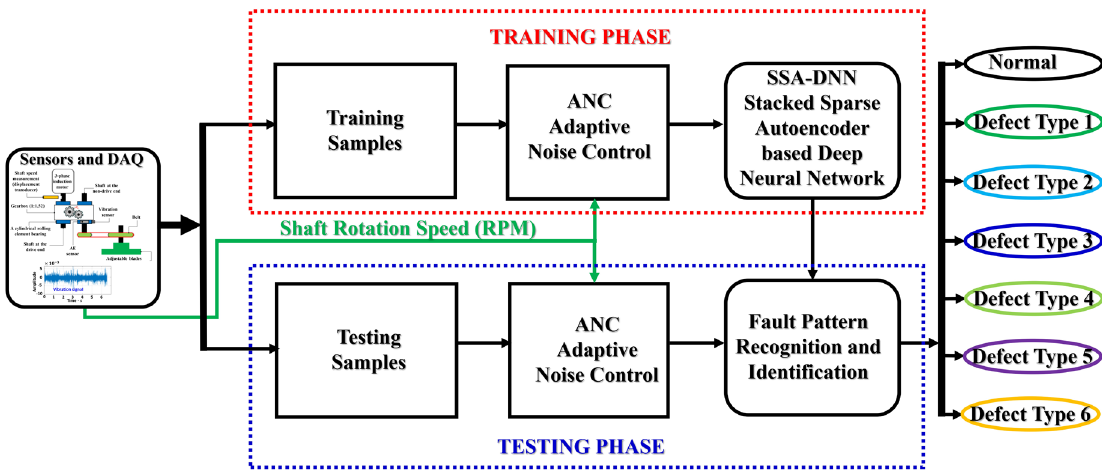
Figure 4. A block diagram of the proposed gearbox fault diagnosis